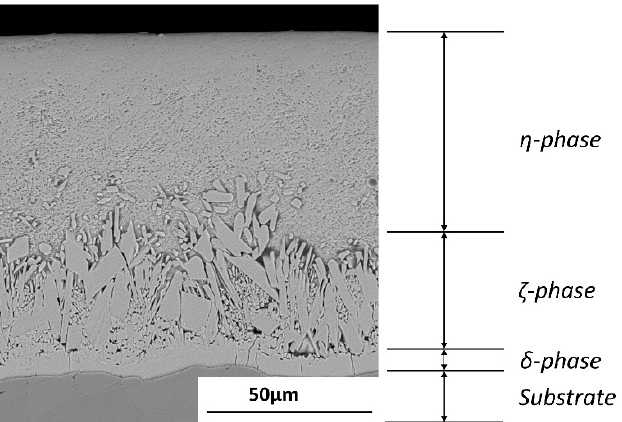
Figure 3. SEM (BSE) image of the different phases of the galvanizing layer.